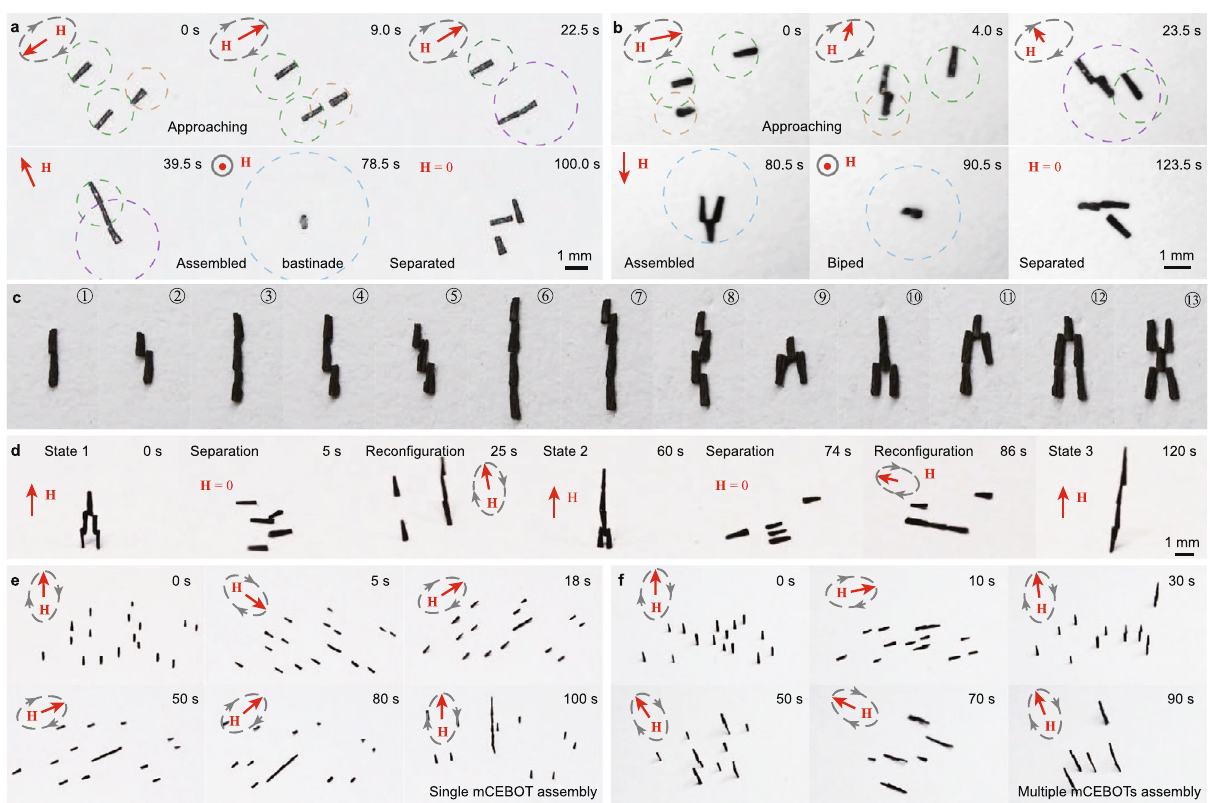
Fig. 3 Multiple con fi gurations of mCEBOT morphologies. a Assembly of bastinade-shaped mCEBOT by end-by-end connection and corresponding separation by removing magnetic fi eld. b Assembly of biped mCEBOT by side-by-side connection and corresponding separation by removing magnetic fi eld. c Protean morphologies achieved by introducing units ’ number and combining two connection methods. d Multiple con fi gurations of mCEBOT ’ s morphologies by controllable assembly and separation. e The construction of single mCEBOT in a large number of robotic units. f The construction of multiple mCEBOTs at the same time in a large number of robotic than its own body length. As the motion trajectory shown in Fig. 4h, the maximum height of the climbing motion can reach 142% of itself body length when the magnetic fi eld with a strength of 100 mT steering 160°. More details about climbing motion of hoe-shaped mCEBOT can be found in Supplementary Fig. 6, Supplementary Movie 2, and Supplementary Note 9.